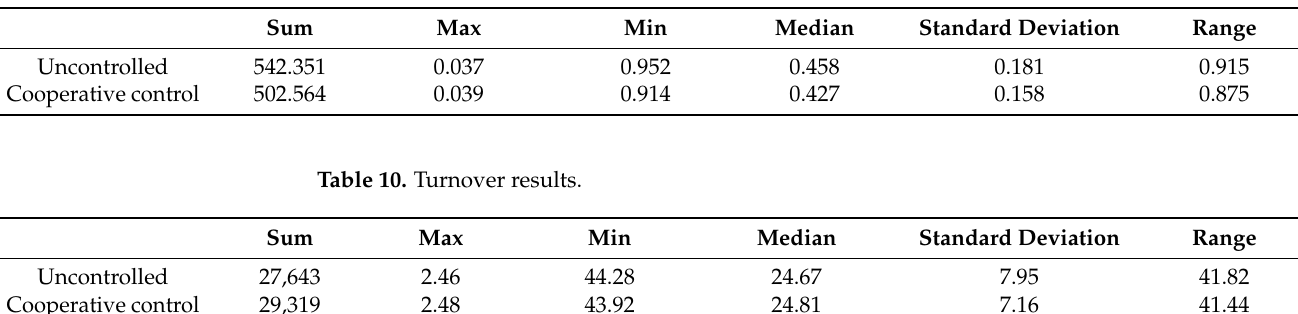
Table 11. Uncontrolled time speed difference.